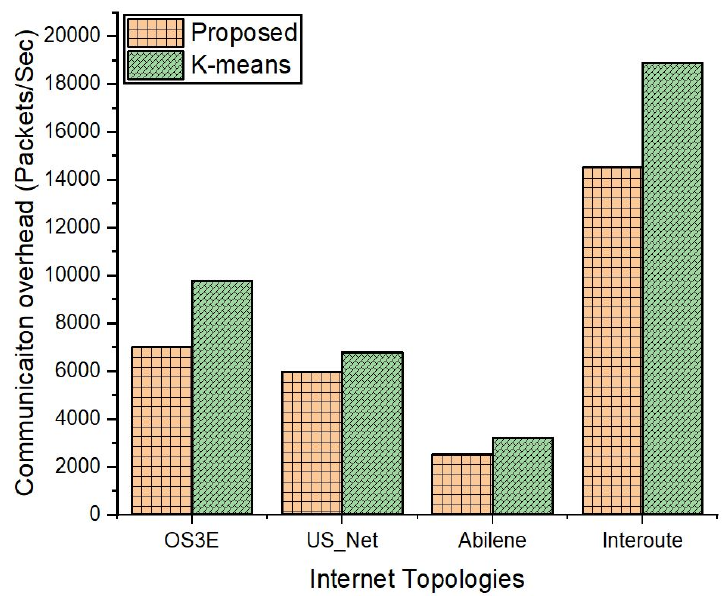
Figure 10. Communication overhead between the switches and controllers.